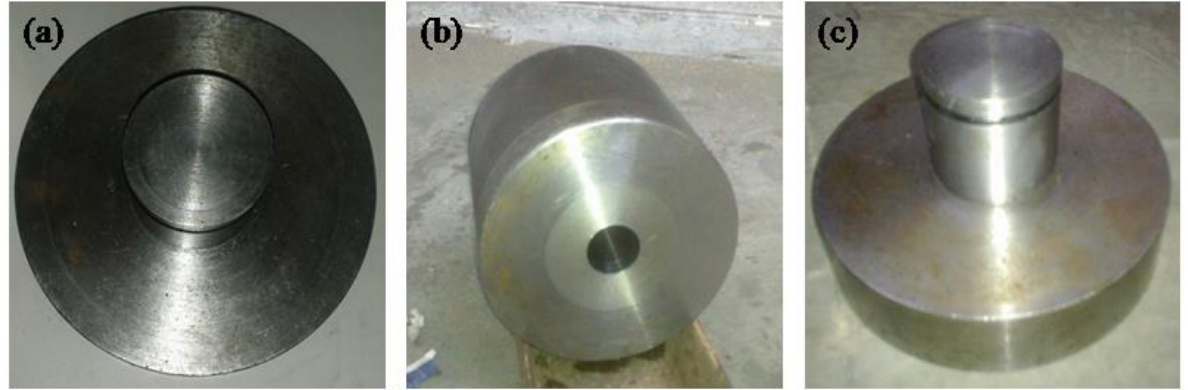
Figure 2. ( a ) Image of Punch, ( b ) Image of Die and ( c ) Image of Ejector.